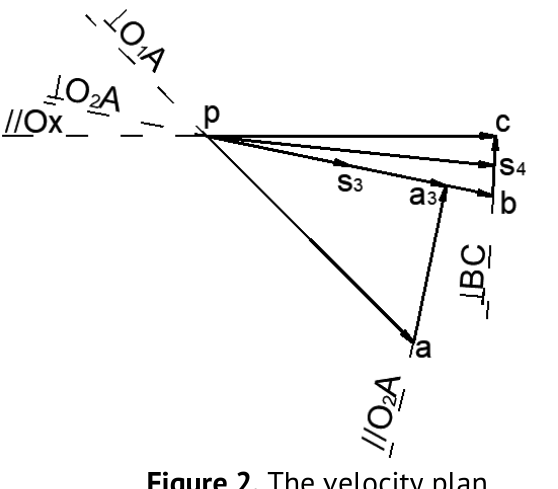
Figure 2. The velocity